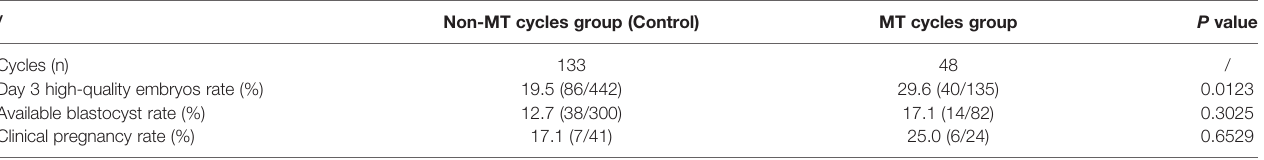
TABLE 4 | Results of repeated-poor-quality-embryo culture treated with MT or not.